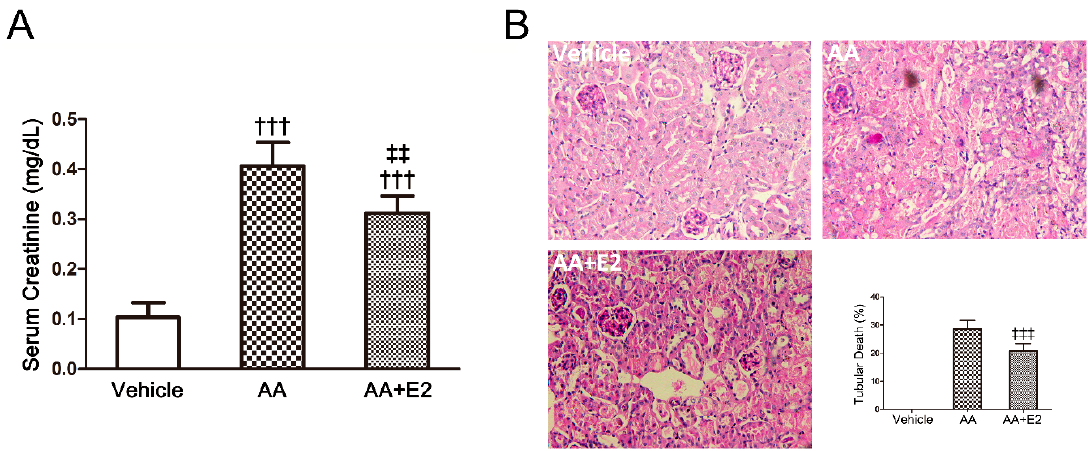
Figure 4. AA-induced acute AAN in male mice at day 5 were attenuated by treatment with E2. ( A ) Measurement of serum creatinine; ( B ) Histology (PAS-stained sections) and quantitative analysis of tubular death. Note that there were less necrotic tubules in AA + E2 group compared with AA group. Data were expressed as means ± SD for groups of 6 mice. ††† p < 0.001 vs. vehicle group; ‡‡ p < 0.01, ‡‡‡ p < 0.001 vs. AA group. Magnification, × 200.